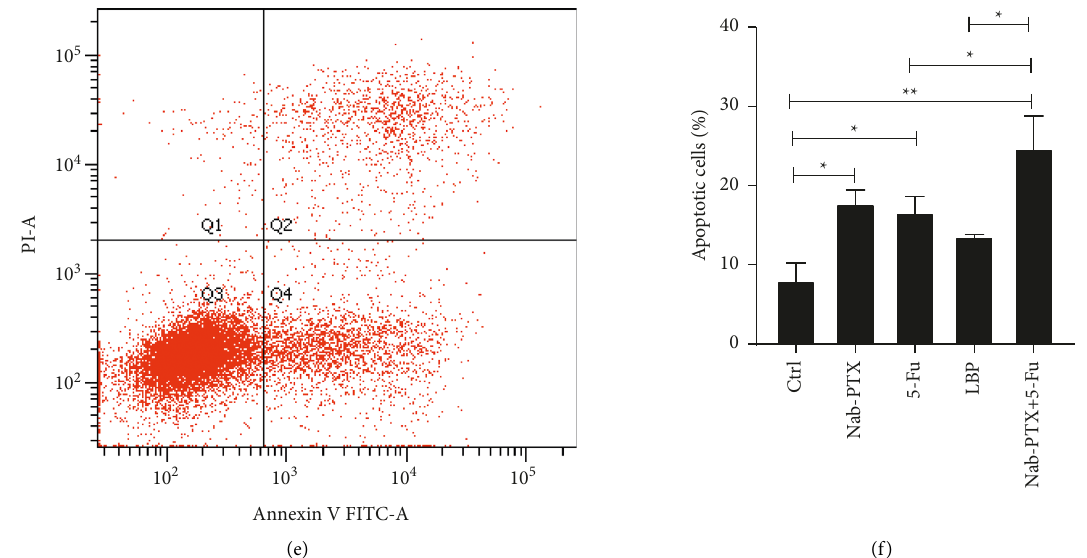
Figure 2: Apoptosis in each group of AGS cells. (a) The 24h apoptosis map of control; (b) the 24h apoptosis map of Nab-PTX(0.2 μ mol/l); (c) the 24h apoptosis map of 5-F(2 μ mol/l); (d) the LBP(10umol/l) 24h apoptosis map; (e) the 24h apoptosis map of Nab-PTX+5-Fu (0.2 μ mol/l +2 μ mol/l); (f) apoptotic cells (%) in different groups, analyzed by Annexin V-FITC/PI and using flow